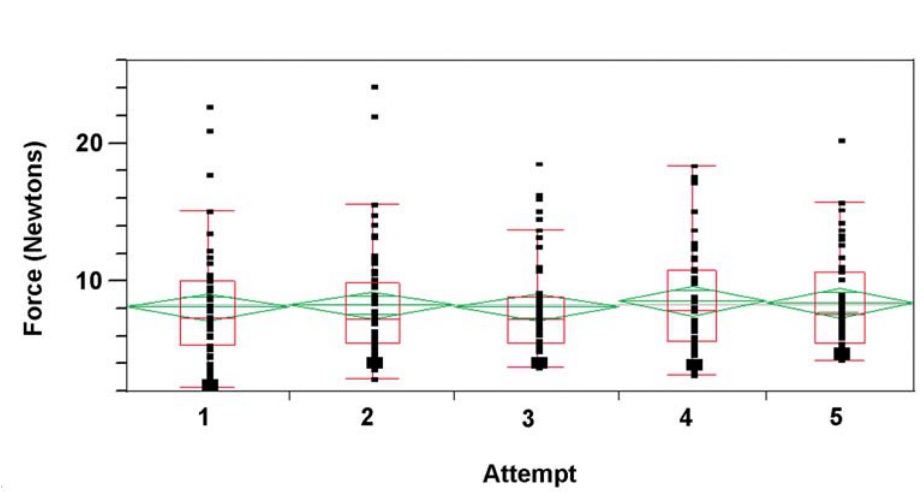
Figure 3 – One way analysis of variance comparing force (y-axis) versus attempt (x-axis). Mean force (green diamond lines) by attempt ranged from 8.14 N - 8.62 N (p =